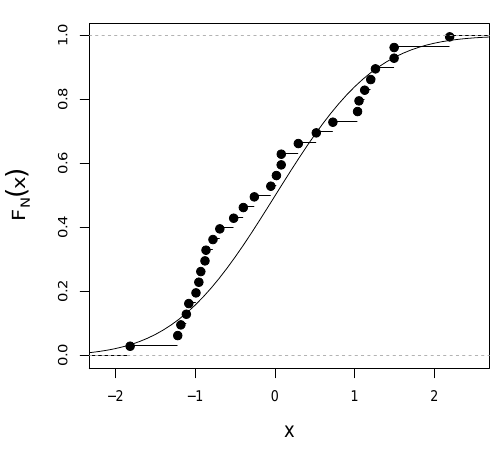
Figure 5: The cumulative distribution function of a standard Gaussian random vari- able together with the empirical distribution function for N = 30 random realisations. small α